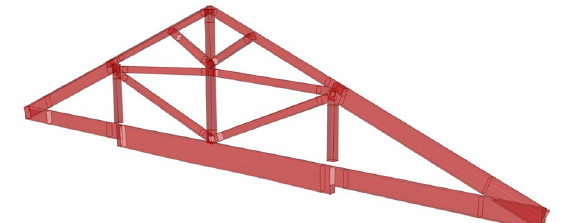
Figure 13: Ideal 3D